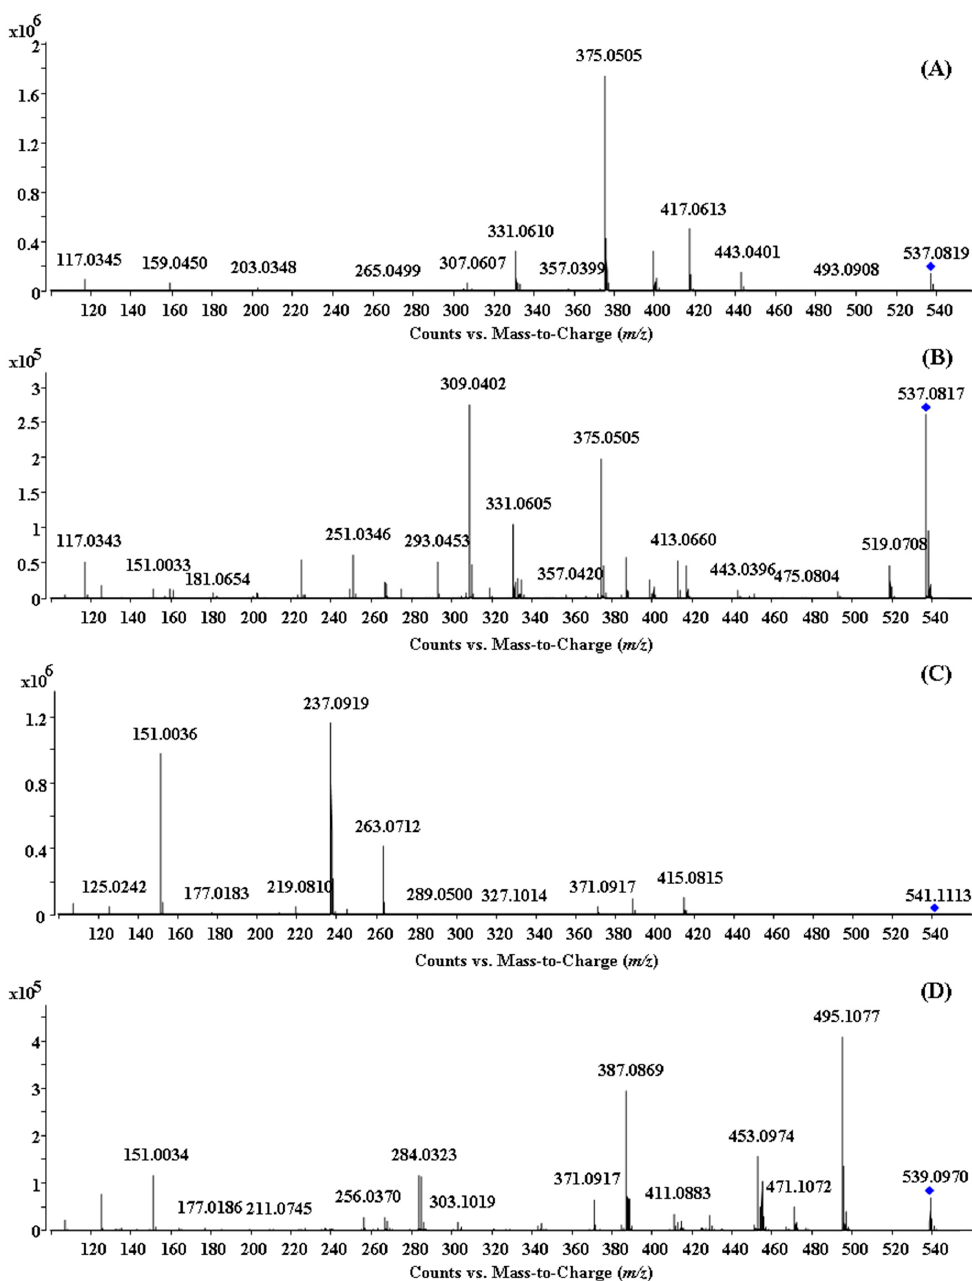
Figure 1. ( − )ESI-QTOF MS/MS spectra of four biflavonoid reference compounds: ( A ) amentoflavone; ( B ) robustflavone; ( C ) 3 ′ ,3 ′′′ -binaringenin; ( D ) chrysocauloflavone I. The [M − H] − ion at m / z 579 of heveaflavone (7,7 ′′ ,4 ′′′ -tri- O -methyl-amentoflavone) yielded the [M − H − C 10 H 8 O 3 ] − ion at m / z 403 corresponding to the 0,4 IIA − ion and 0,4 IIA − − CH 3 • ion at m / z 388 in